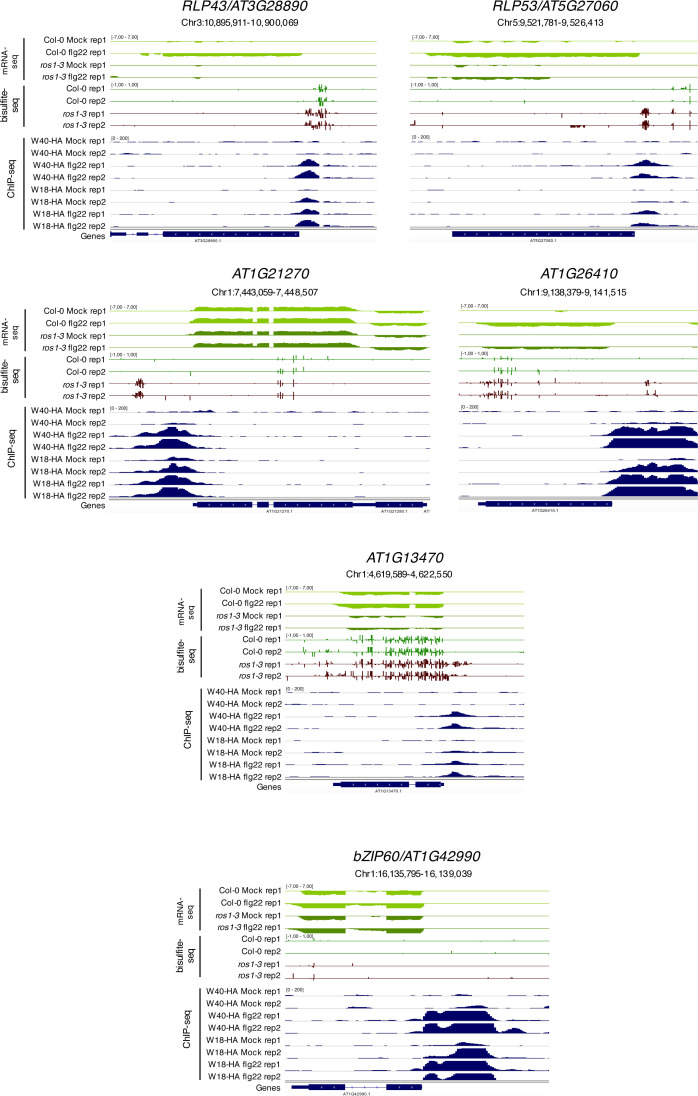
Flg22-triggered chromatin association of WRKY18-HA and WRKY40-HA at the promoters of five less-induced ROS1 targets and at the promoter of the positive control bZIP60.Snapshots representing mRNA-seq and BS-seq of Col-0 and ros1 untreated rosette leaves and ChIP-seq data for wrky18 WRKY18-HA and wrky40 WRKY40-HA seedlings subjected to either mock (medium without flg22) or flg22 (medium supplemented with flg22) for 2 hr, at RLP43, RLP53/AT5G27060, AT1G21270, AT1G26410, AT1G13470, and bZIP60 (Birkenbihl et al., 2017).